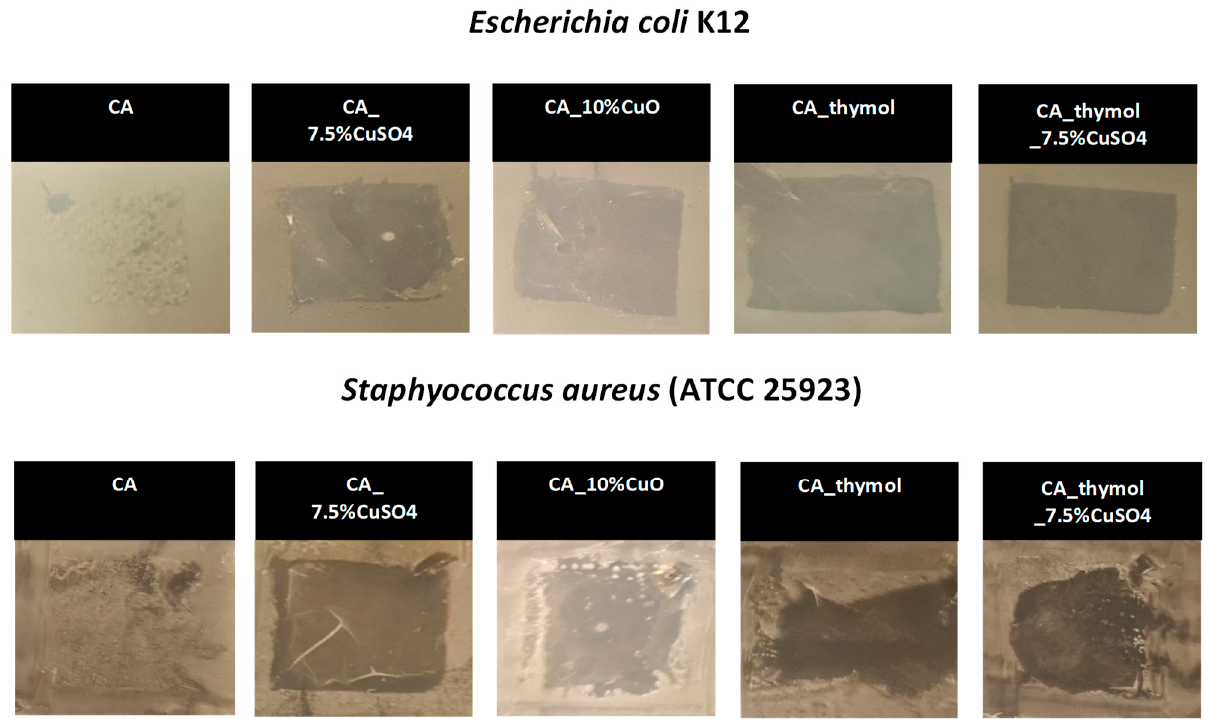
Figure 3. Antibacterial activity of filter materials against bacteria Escherichia coli and Staphylococcus aureus. The filter materials were removed for the images to demonstrate the bacteria-free area under the materials.